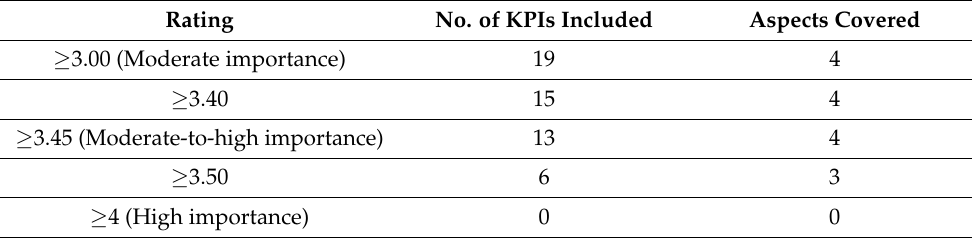
Table 5. Scenarios of cutoff